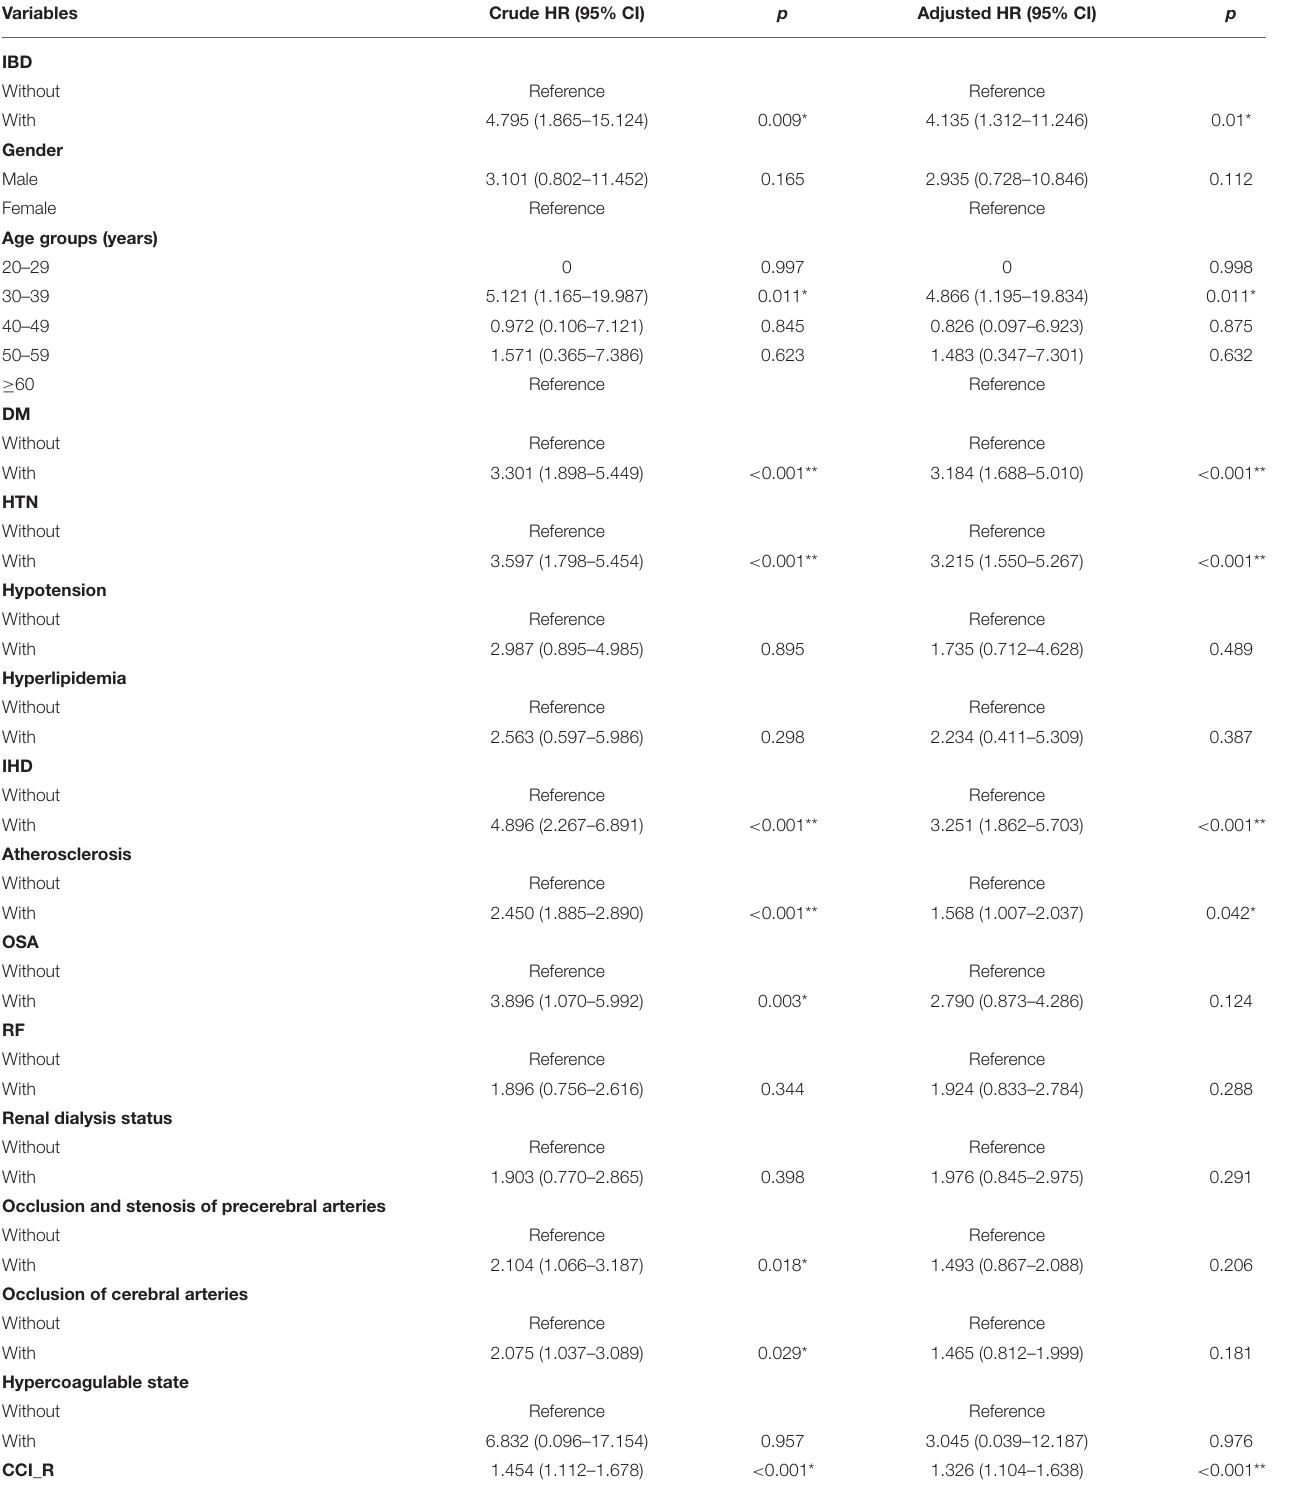
TABLE 2 | Risk analysis for ischemic optic